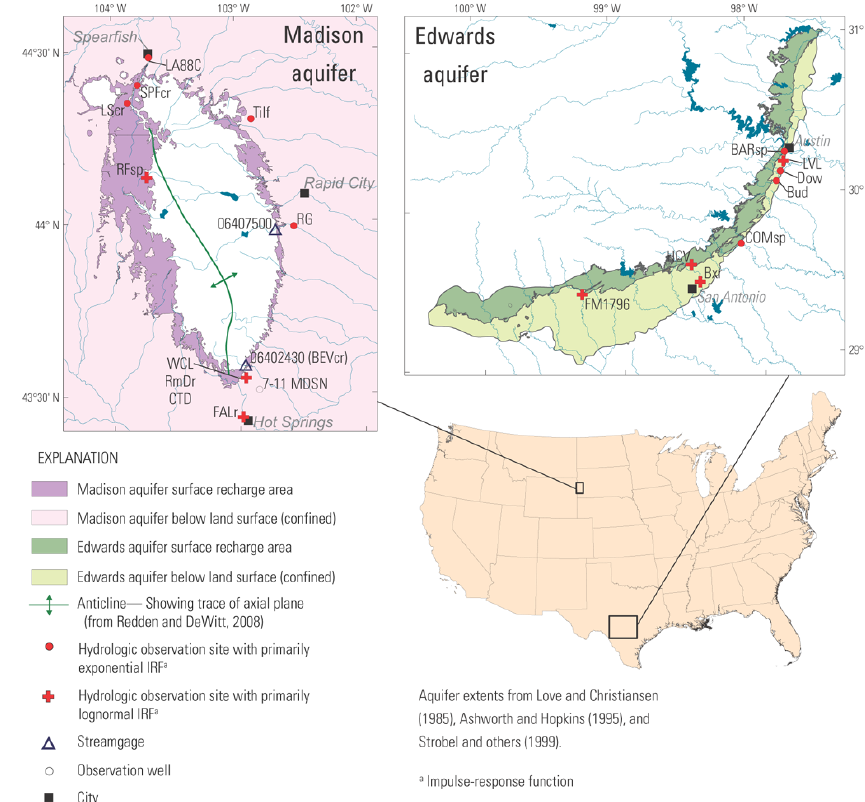
Fig. 2. Study areas showing the Madison and Edwards aquifers.